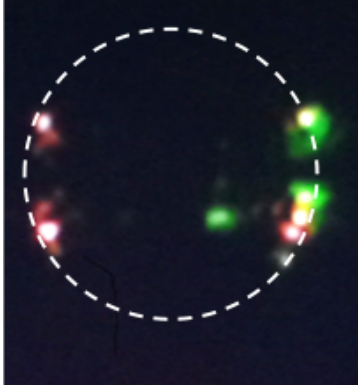
Figure 7. Optical picture of the microsphere showing the TSFG standing wave in the red and the traveling wave in the green of the THG.